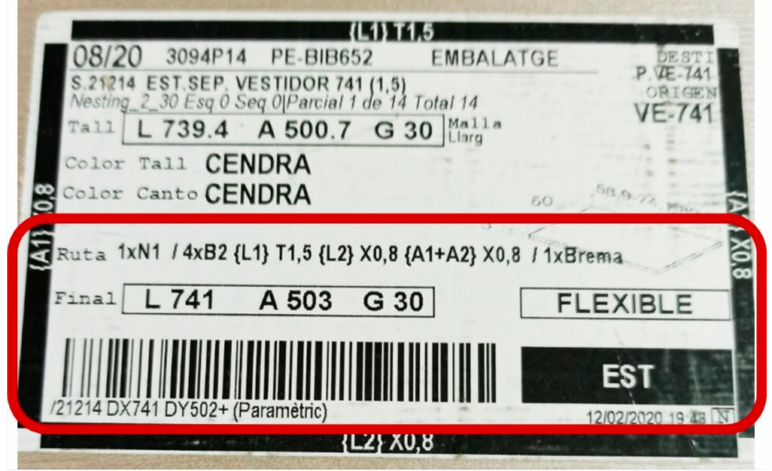
Figure 3. Detail of label attached to